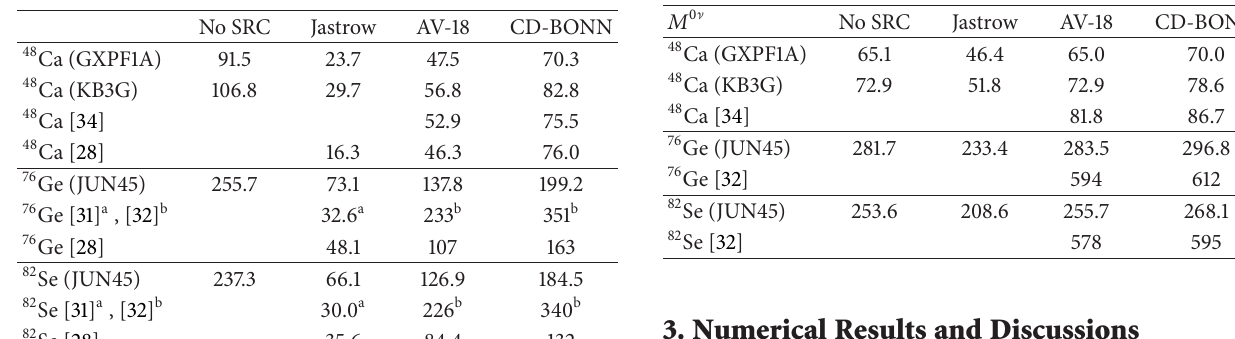
Table 3: 0 ] 𝛽𝛽 NMEs values for SUSY2 mechanism and comparison to other results in the